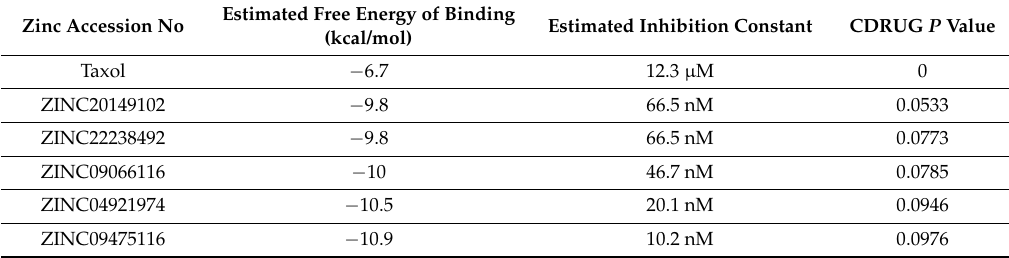
Table 2. List of putative and known inhibitors (Taxol) for FLD of the physiological Bcl-2 form. The putative inhibitors were identified from HTVS and docking analysis against the Zinc Database [55] (ranked according to CDRUG [54] P-Value).